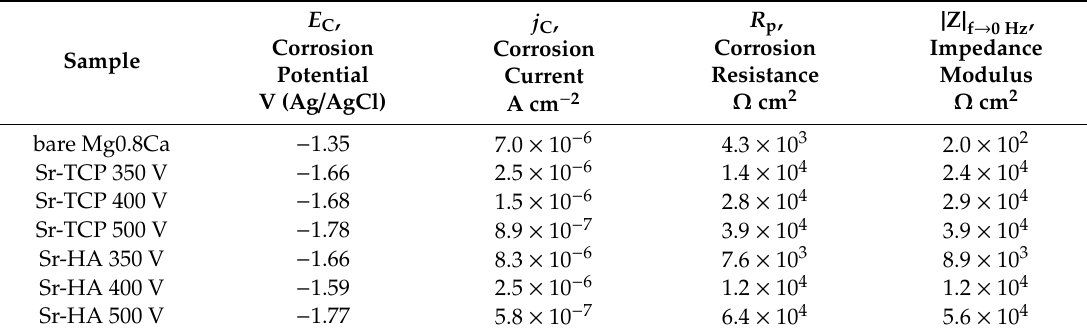
Table 2. Calculated electrochemical parameters of the